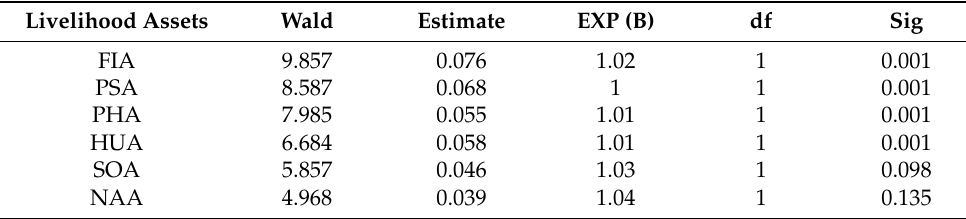
Table 7. The impacts of livelihood assets on food security.